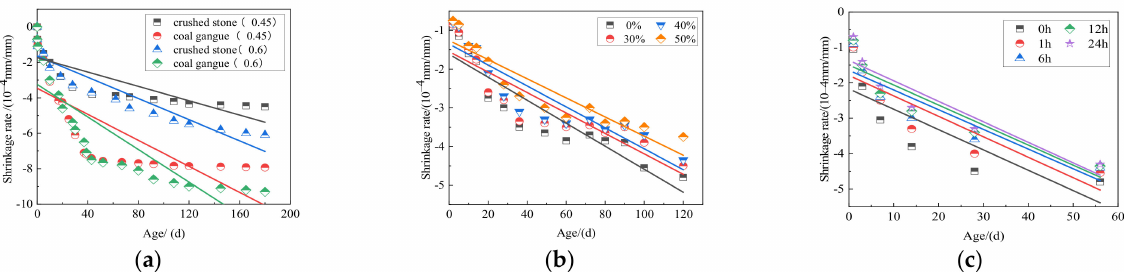
Figure 17. ( a ) Effect of different water-binder ratios on concrete shrinkage [91]; ( b ) Effect of different displacement rates of coal gangue on concrete shrinkage [92]; ( c ) Effect of prewetting time on shrinkage rate